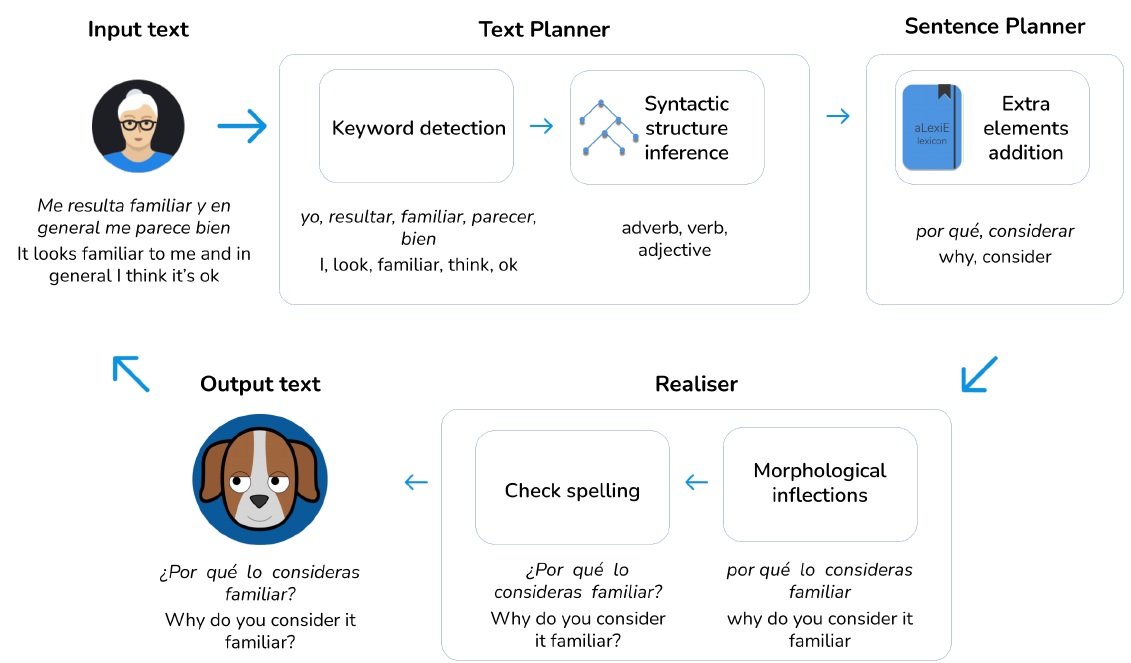
Figure 3. Text expansion